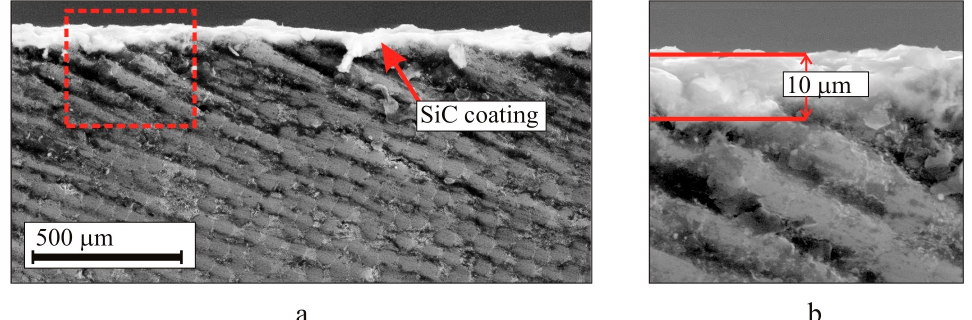
Figure 4. Cross-section of a CCCM with a protective gas-tight SiC coating ( a ) and its enlarged fragment ( b ).